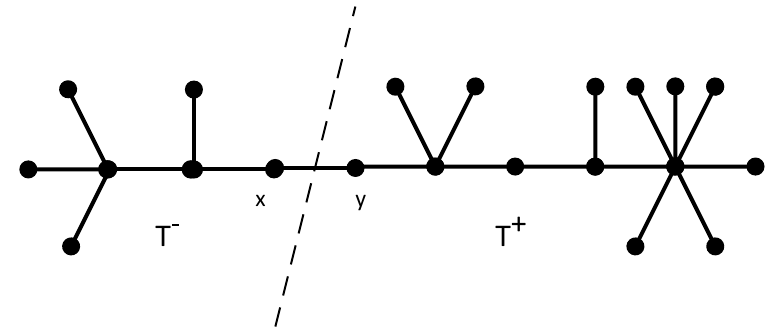
Figure 3: The positive-subtree 𝑇 + and negative-subtree 𝑇 − of a tree 𝑇